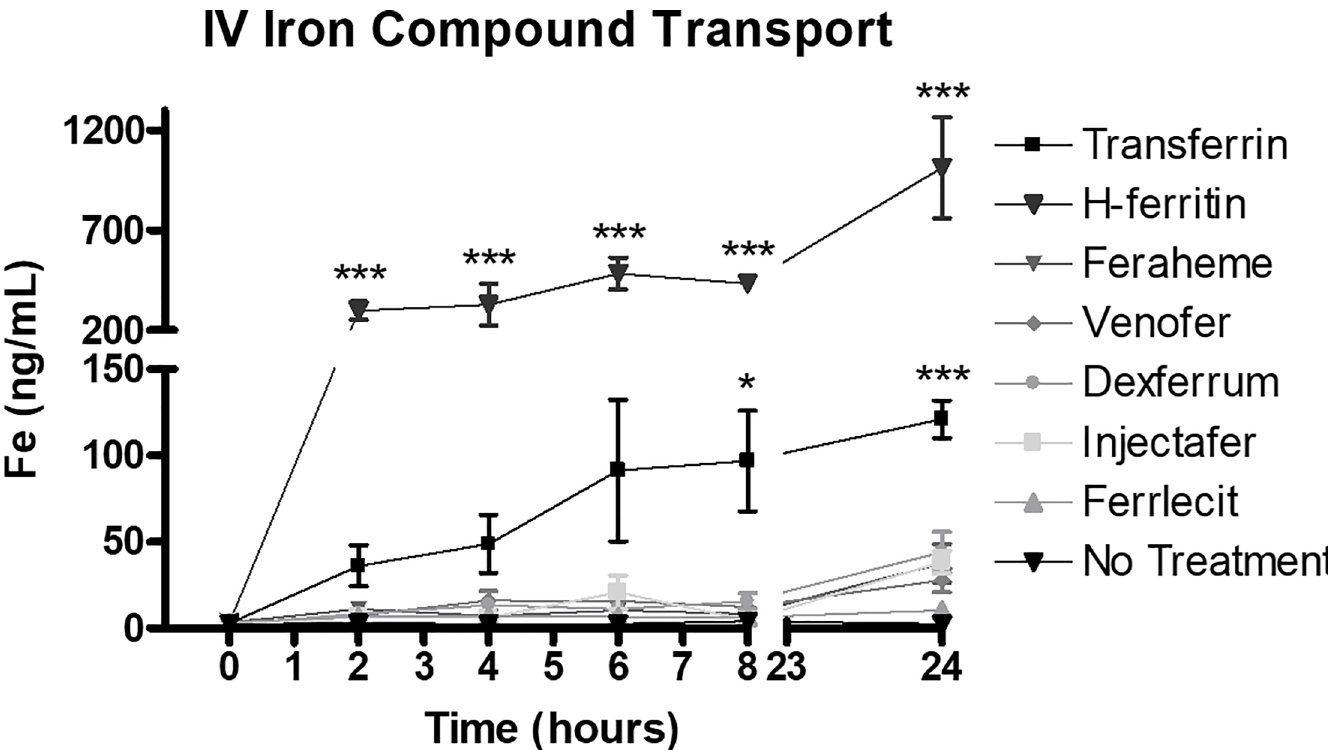
Fig 1. Commercial iron formulations do not transport iron across a BBB model. Using the bichamber model of the BBB, H-ferritin and Tf robustly transport iron across the huECs at each time point. Minimal iron transport is observed for the 5 commercial iron formulations. The concentration of the commercial formulations, Tf and H-ferritin was 300 μ g/ml. All values are means ± SD, with statistical significance evaluated against the untreated control using two-way ANOVA and Bonferroni’s post hoc comparisons. (cid:3) = p < 0.05, (cid:3)(cid:3)(cid:3) = p < 0.001.